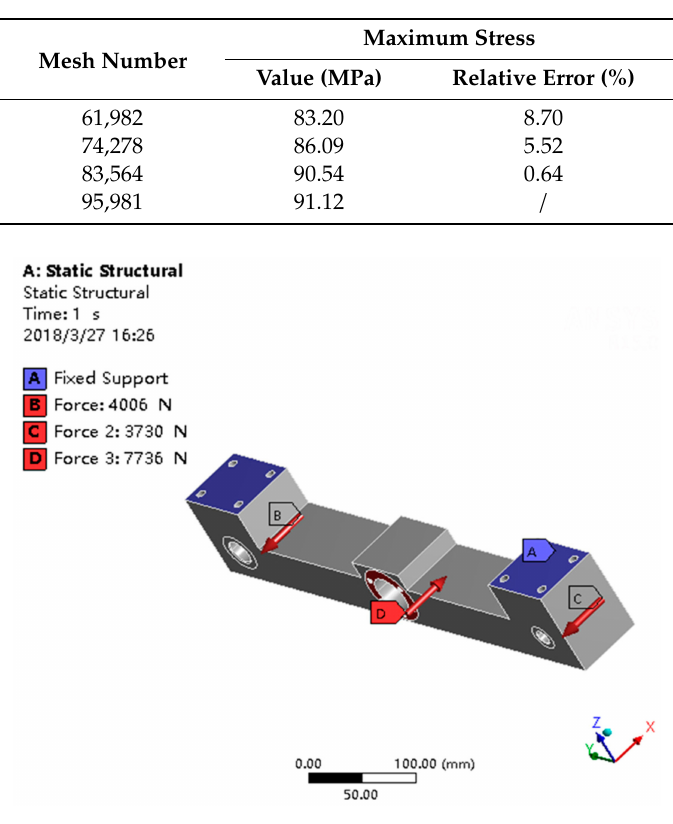
Table 3. Grid independence calculation for the knockout plate.